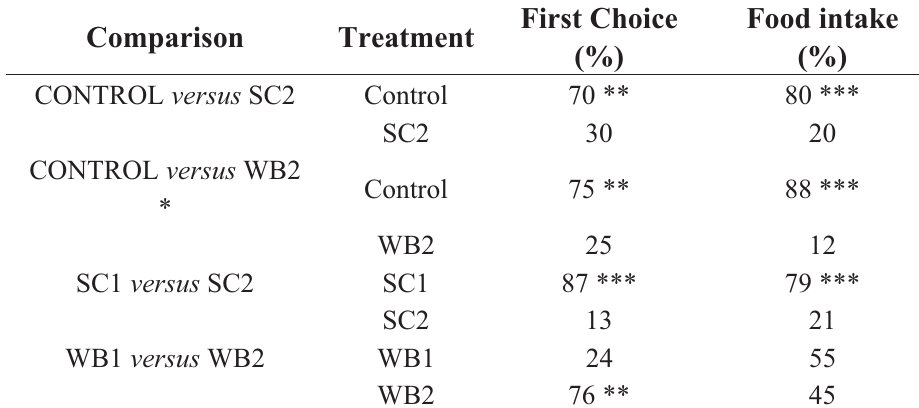
Table 4. Palatability testing